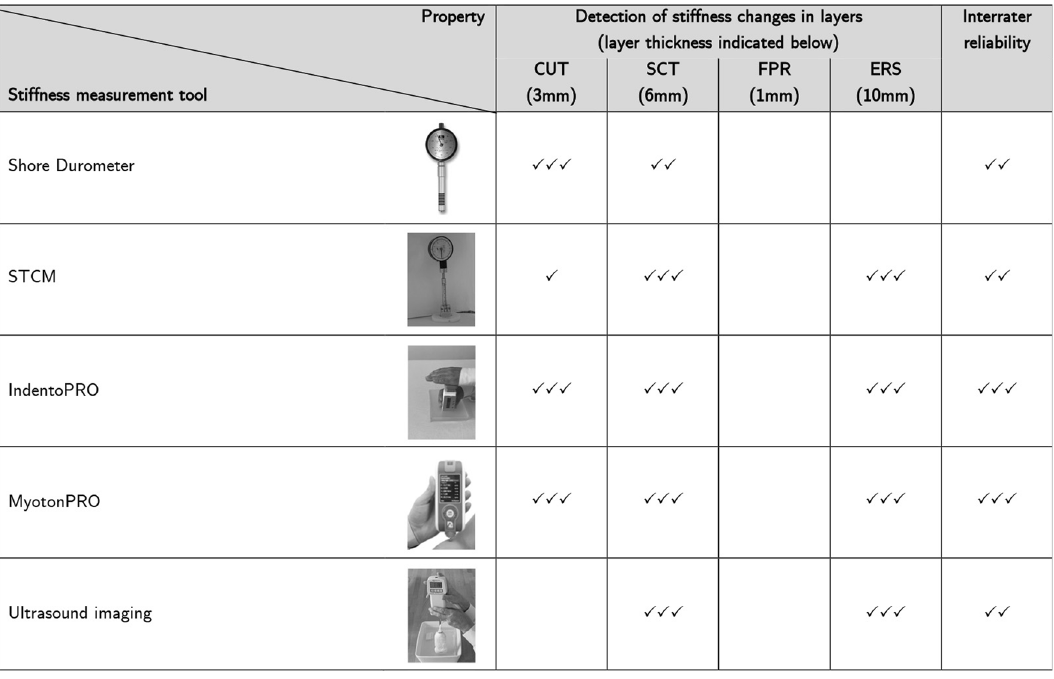
Figure 3. CUT cutis. SCT subcutaneous connective tissue. FPR fascia profunda. ERS erector spinae. Blank denotes “no reliable measurement possible”. ✓ denotes moderate correlation (> 0.4). ✓✓ denotes strong. correlation (> 0.7). ✓✓✓ denotes very strong correlation (> 0.9). Photos (1st to 5th row): rows 1–3: fasciaresearch.org with permission; myotonpro.com with permission, fasciareasearch.org with